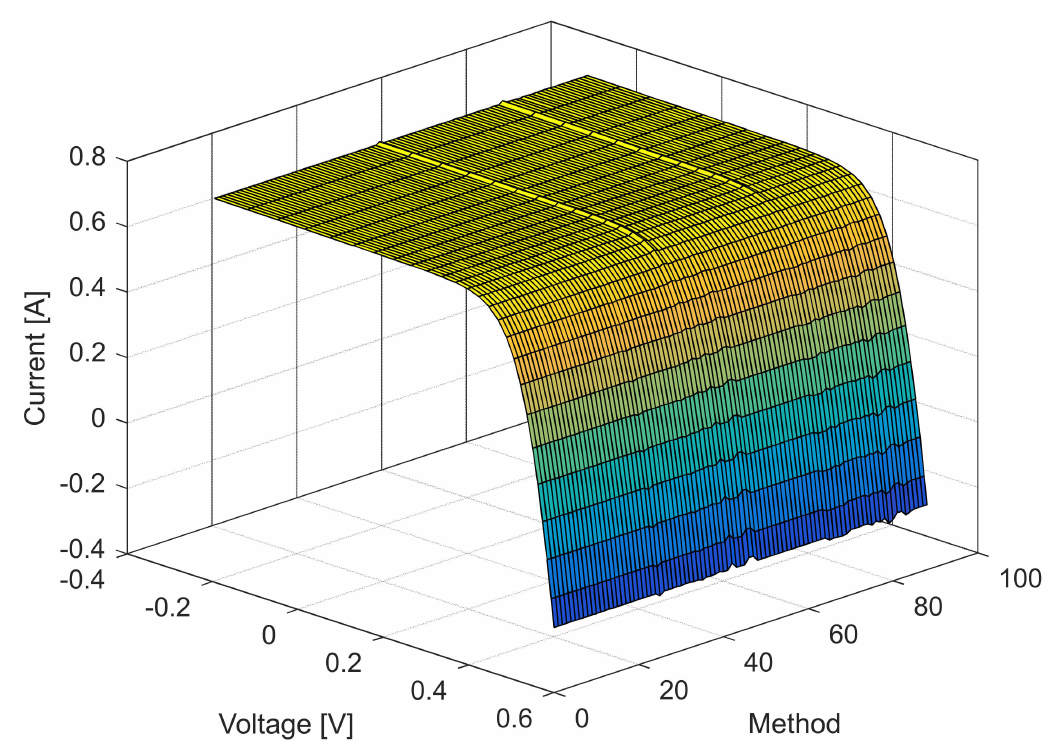
Figure 6. Current–voltage characteristics for the methods listed in Table 2.